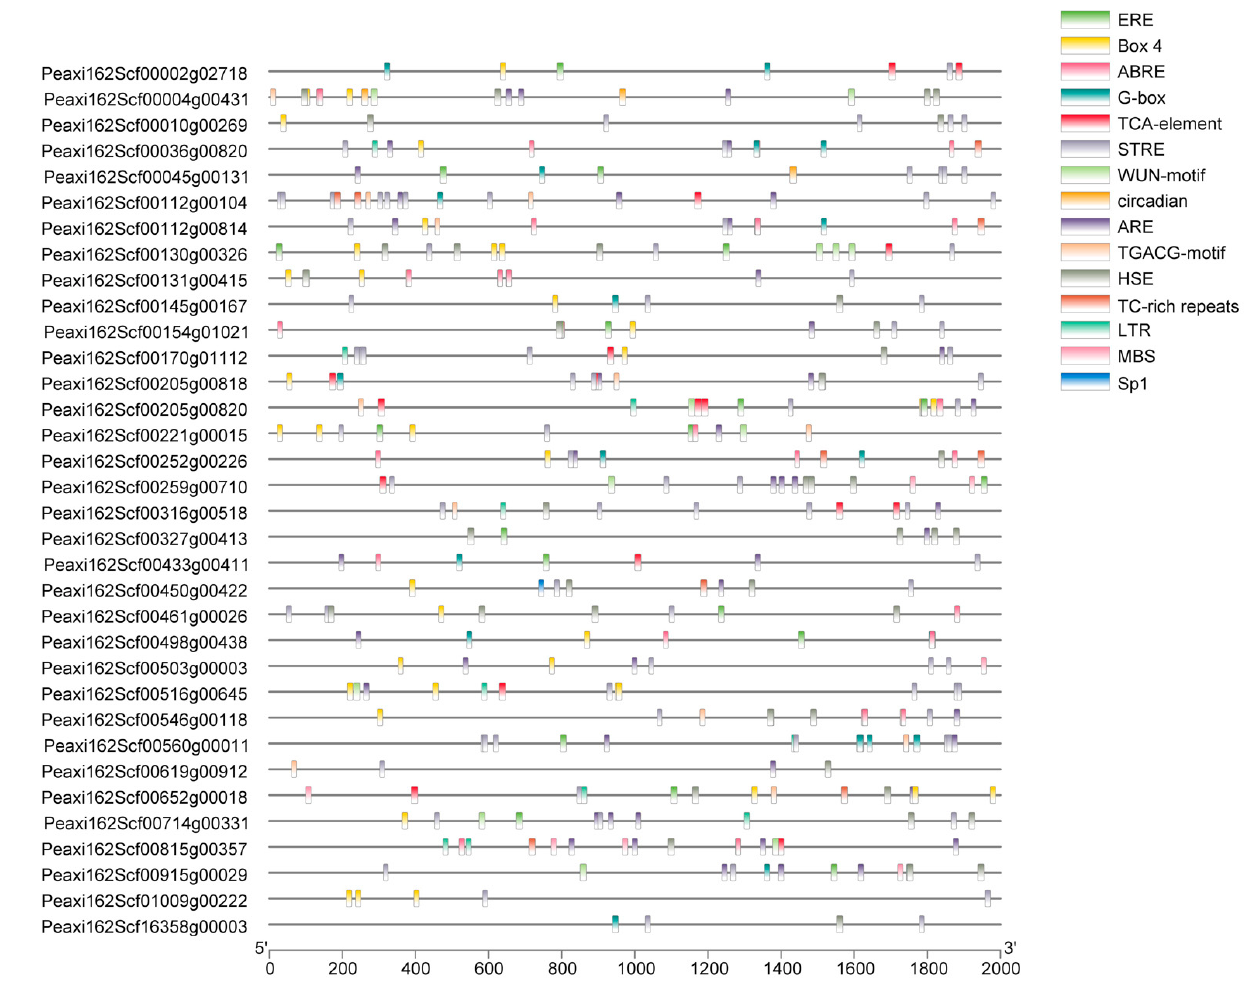
Figure 4. Cis -acting elements analysis of promoter sequences of petunia HSFs. The position of cis -acting elements in the 2kb upstream region is represented by different colored bars.